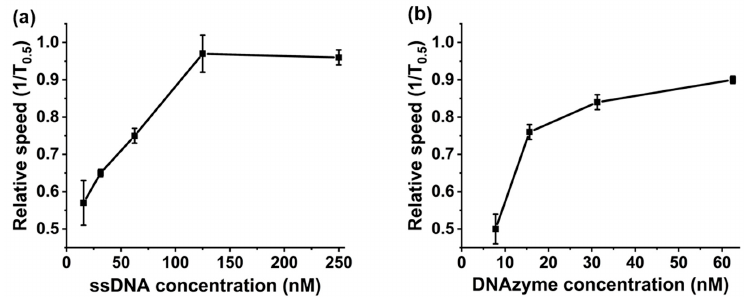
Figure 2. ( a ) Determining the concentration of substrate strand DNA required to saturate the